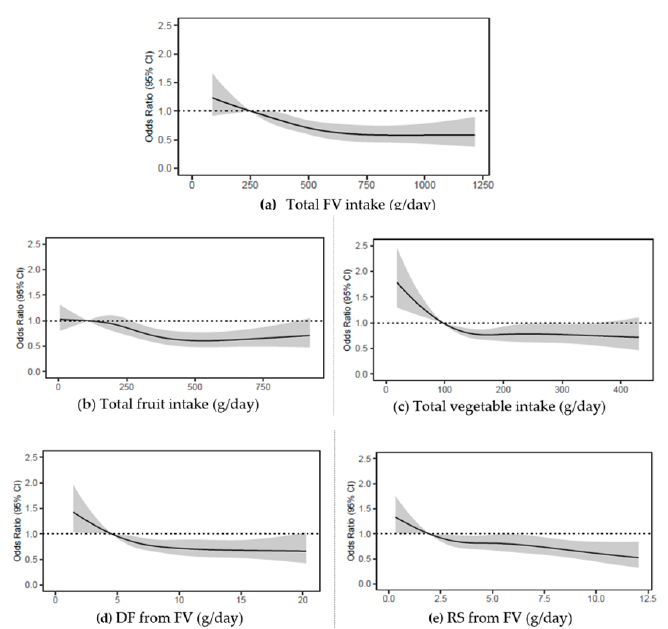
Figure 3. Odds ratios from logistic regression models with restricted cubic spline curves describing the association of baseline intakes of ( a ) FV combined, ( b ) fruits, ( c ) vegetables, ( d ) DF from FV, ( e ) RS from FV in g/day, with 5-year MCS scores (vertical axis) in 4067 Australian adults from the AusDiab study (excludes those with baseline MCS score < 47). Odds ratios are based on models adjusting for age, sex, BMI, energy intake, relationship status, physical activity, level of education, the socio-economic index for areas (SEIFA), smoking status, diabetes status, and self-reported history of CVD, and are comparing the specific level of intake (horizontal axis) to the median (IQR) intake for participants in the lowest intake quartile (FV combined: 251 g/day; fruits: 106 g/day; vegetables: 97 g/day); DF from FV: 5 g/day; RS from FV: 2 g/day. DF, dietary fibre; FV, fruit and vegetables combined; MCS, SF-36 Quality of Life Scale—Australian norm-based mental component score median; RS, resistant starch.